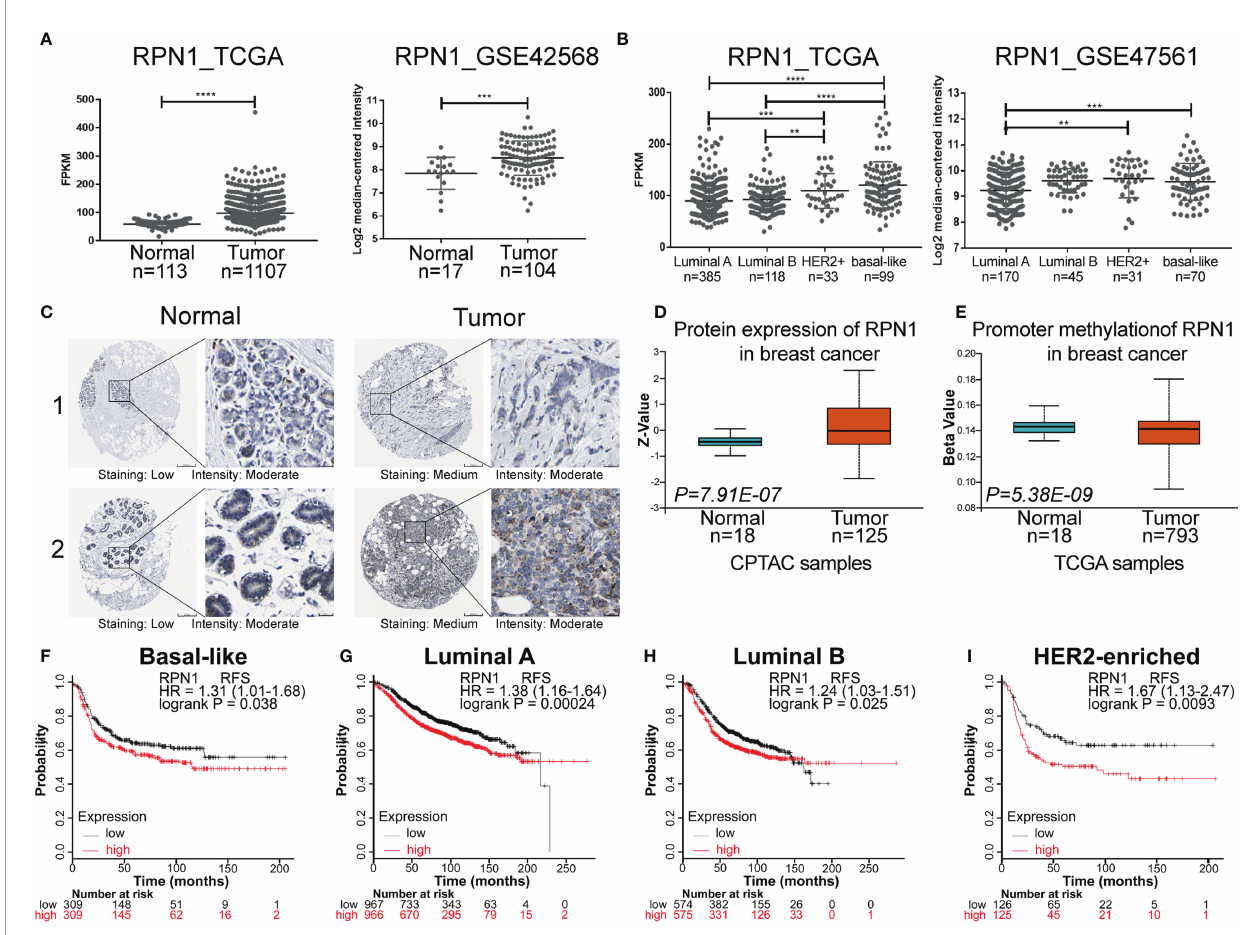
FIGURE 6 | The expression status and prognostic value of RPN1 in BC. (A) Gene expression analysis of RPN1 in BC tissues and normal breast tissues according to TCGA database and GEO database (GSE42568). (B) Gene expression analysis of RPN1 in different subtypes of BC according to TCGA database and GEO database (GSE47561). (C) Representative IHC staining of RPN1 expression in BC tissues and normal tissues according to the HPA database. (D) The protein expression of RPN1 in BC tissues and normal tissues in CPTAC samples according to the UALCAN database. Z-values represented standard deviations from the median across samples. (E) The promoter methylation level of RPN1 in BC tissues and normal tissues in TCGA samples according to the UALCAN database. The Beta value indicated the level of DNA methylation ranging from 0 (unmethylated) to 1 (fully methylated). (F – I) RFS for RPN1 in BLBC, Luminal A, Luminal B, and HER2-enriched BC. P<0.05 was considered statistically signi fi cant. **P < 0.01, ***P < 0.001 and ****P <